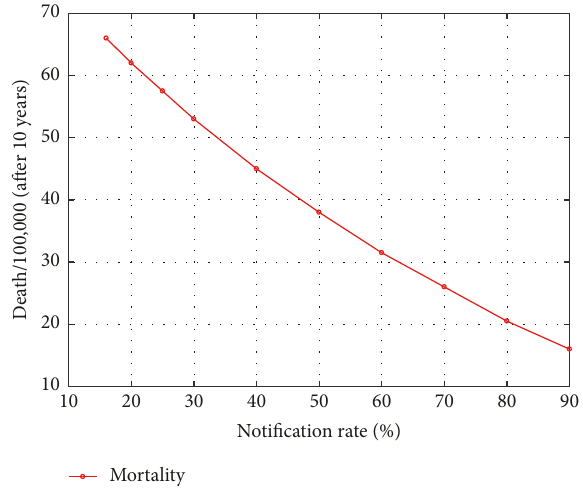
Figure 9: Hypothesis 4: The figure shows the decrease in mortality due to tuberculosis in the sick population for a period of 10 years with different notification levels. The red curve represents the current mortality due to tuberculosis in Nigeria (baseline), and the rest of the curves show what the situation would look like if the notification were to be different.